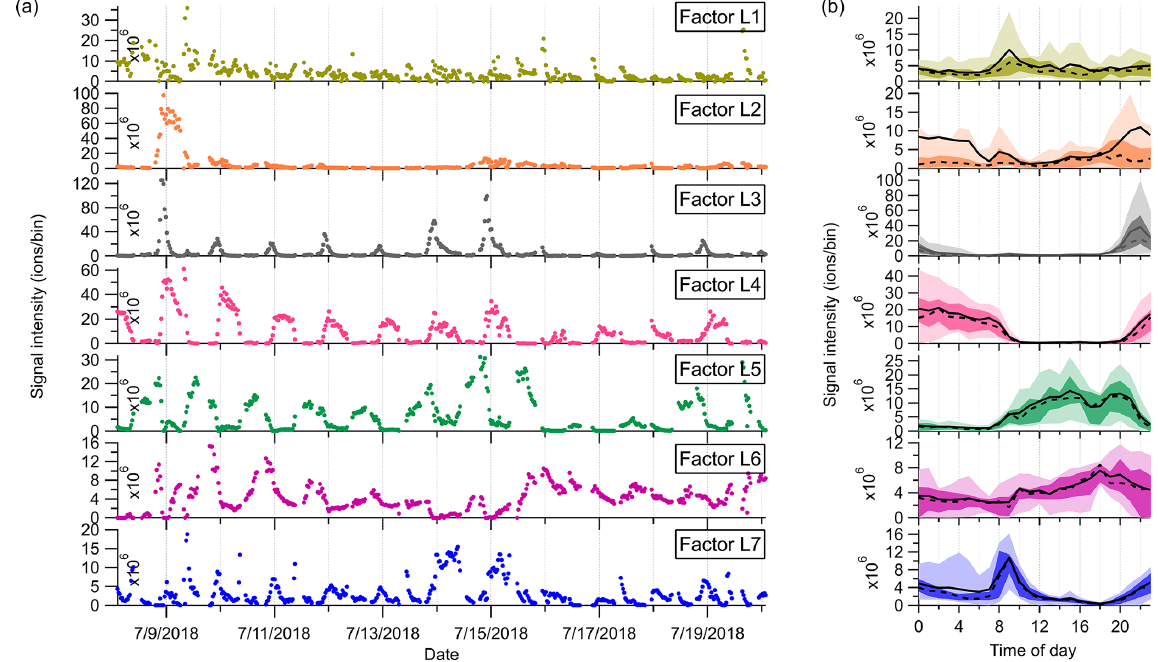
Figure 4. (a) Time series and (b) diurnal variations of the seven factors identified in the low-mass range in the Landes forest. The solid and dashed lines in the diurnal plots show the mean and median values, respectively, and the shaded area shows 10th, 25th, 75th, and 90th